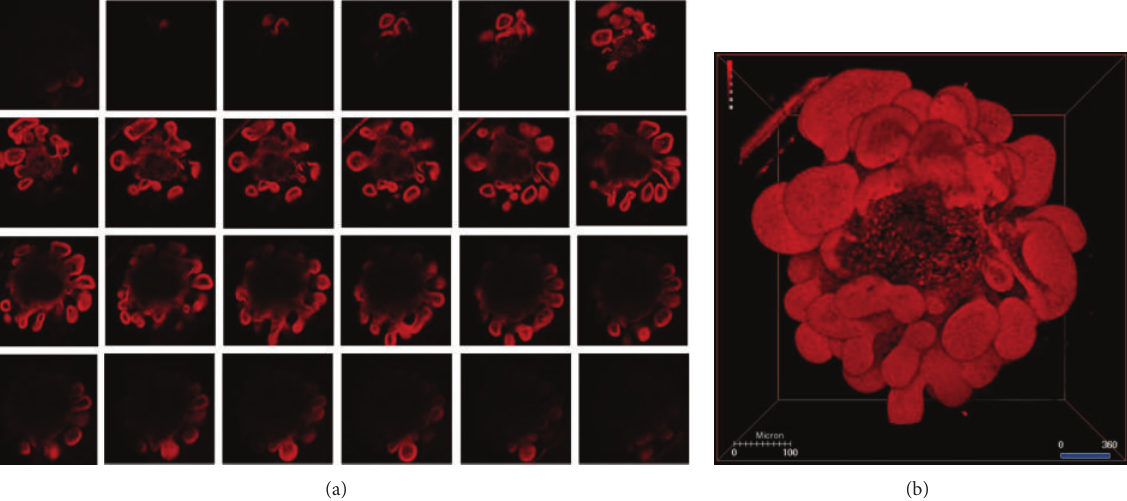
Figure 2: Serial confocal microscopy images and 3-dimensional reconstruction of the propidium iodide-labeled crypt organoid. (a) Serial sections from the top to the base of the crypt organoid. (b) 3D reconstruction from these serial images. Bar: 100 𝜇